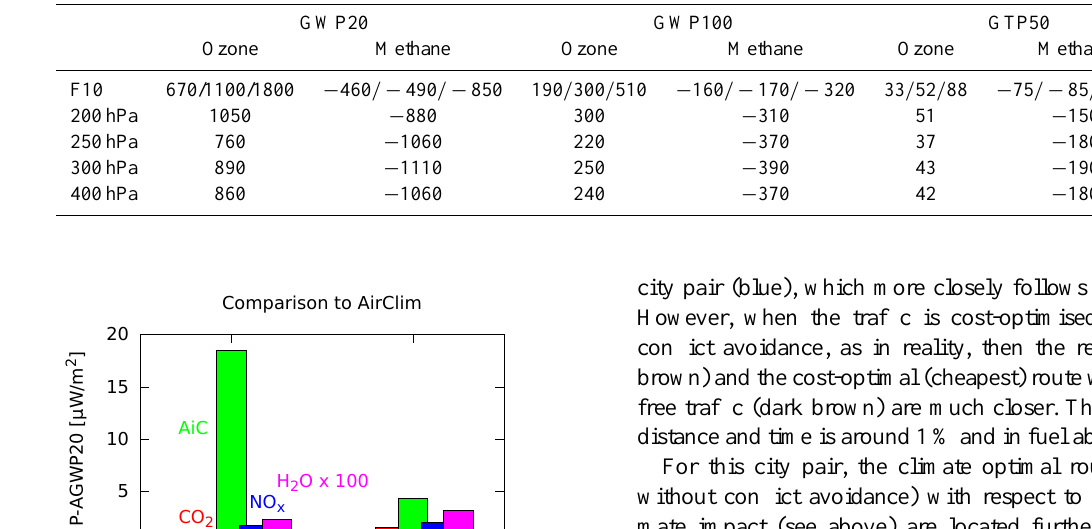
Table 8. Comparison of simulated GWP20, GWP100 and GTP50 values for ozone (short-lived only) and methane for emissions of NO x in the domain indicated in Table 2 with results from three different studies published in Fuglestvedt et al. (2010), abbreviated as F10.